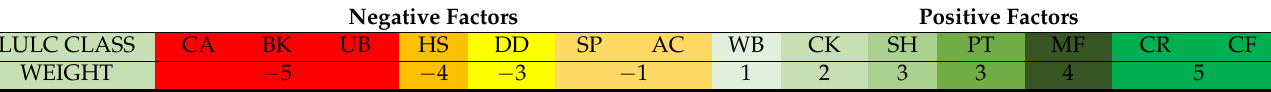
Table 2. Index of positive and negative factors of influence on forest ecosystem. Here, the color gradient from gold accent towards red depicts negative weingting score, whereas from green accent towards green represent positive weigting score. Negative Factors Positive Factors LULC CLASS CA BK CF